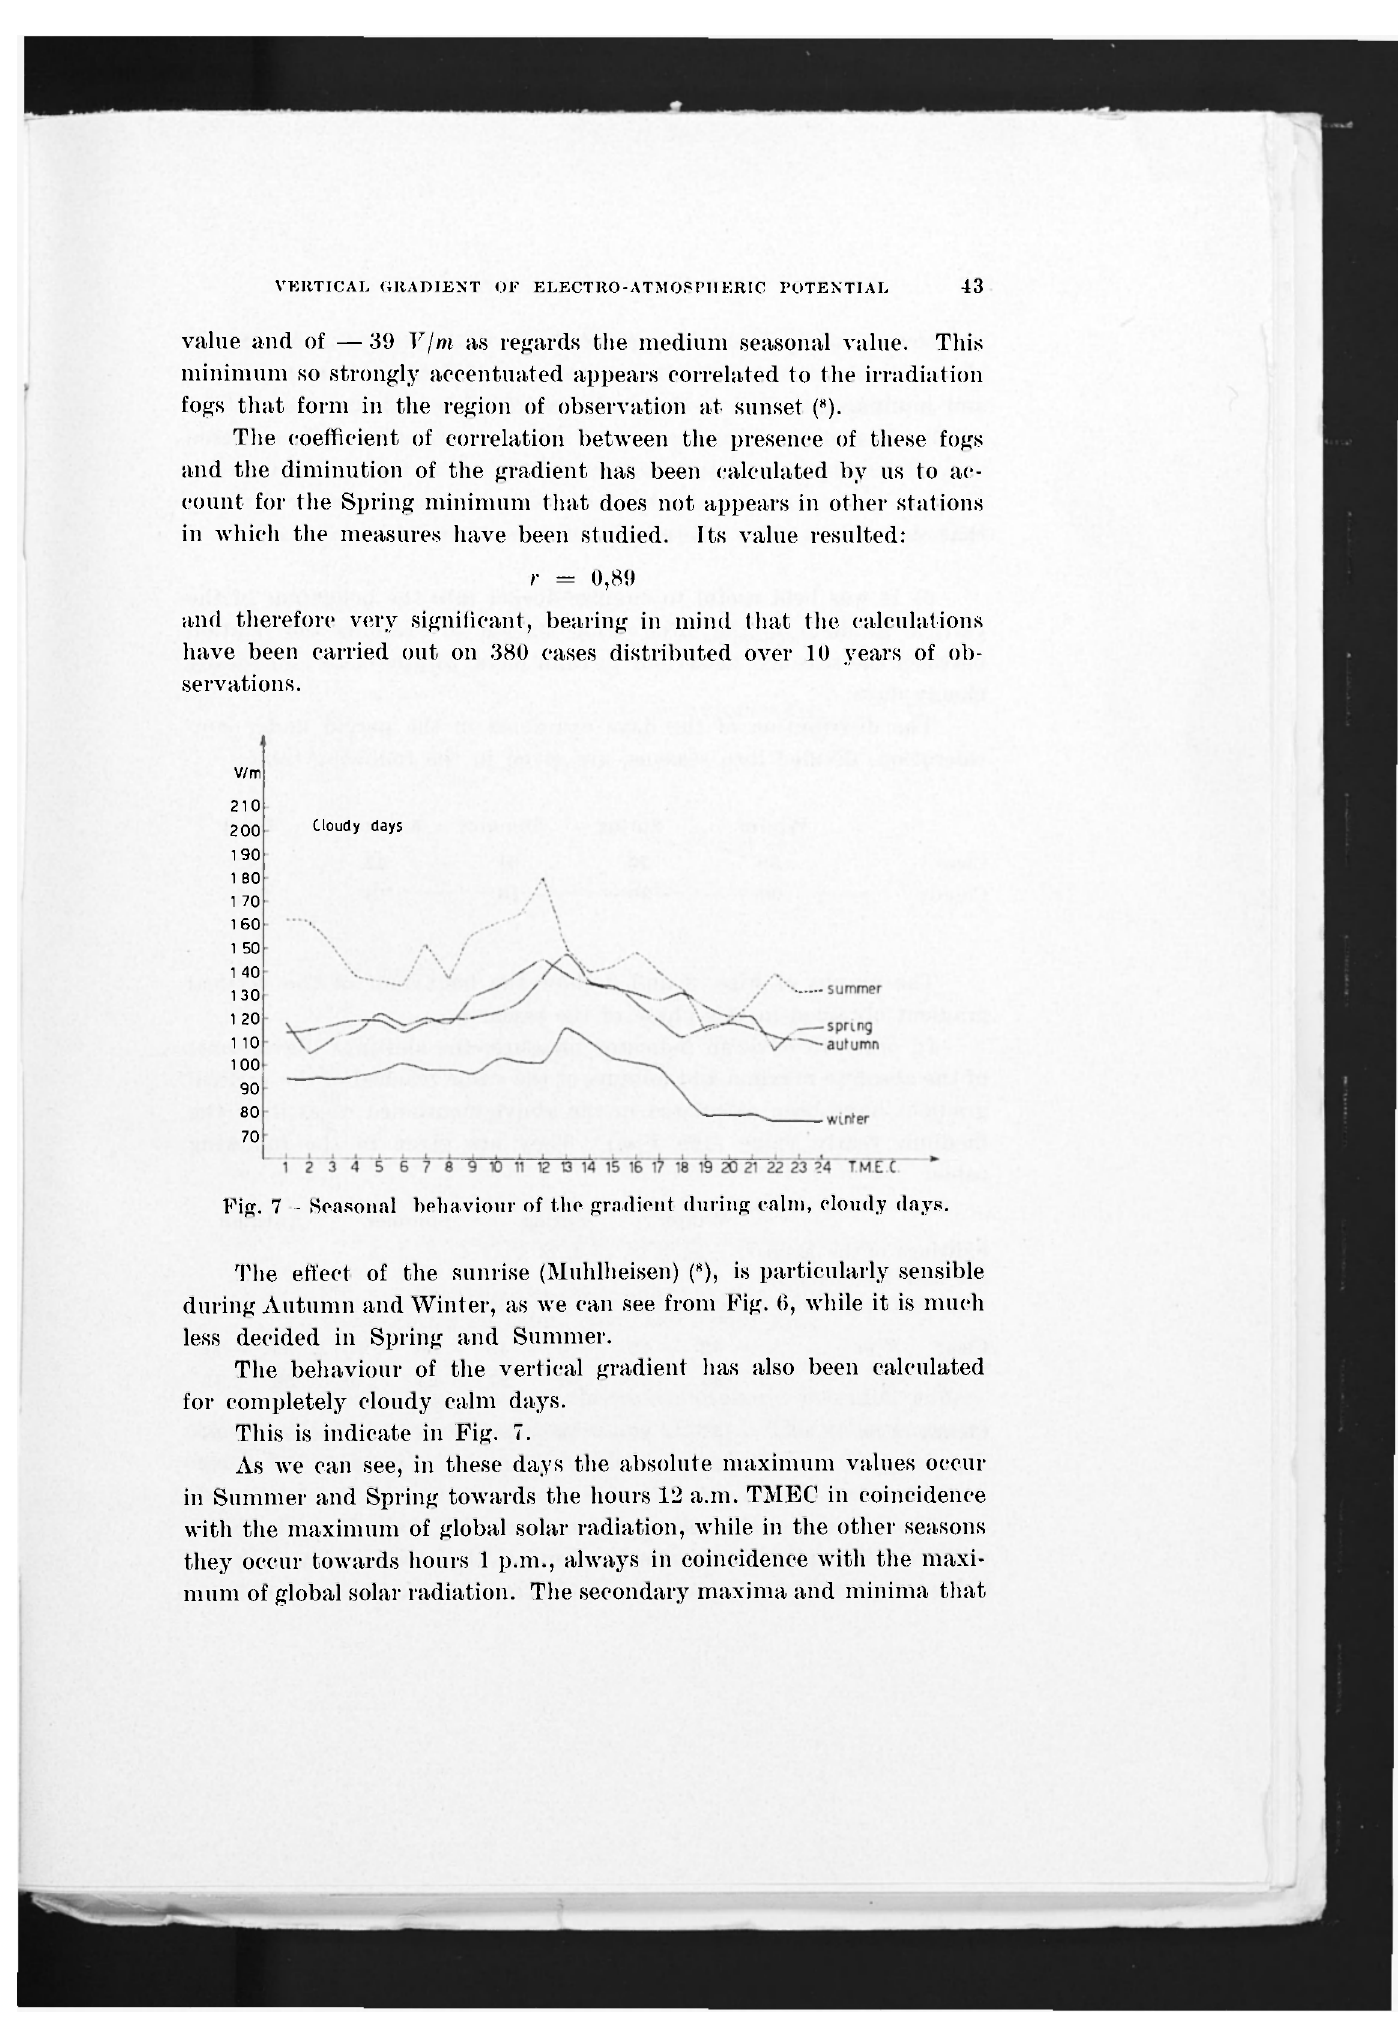
Fig. 7 - Seasonal behaviour of the gradient during calm, cloudy